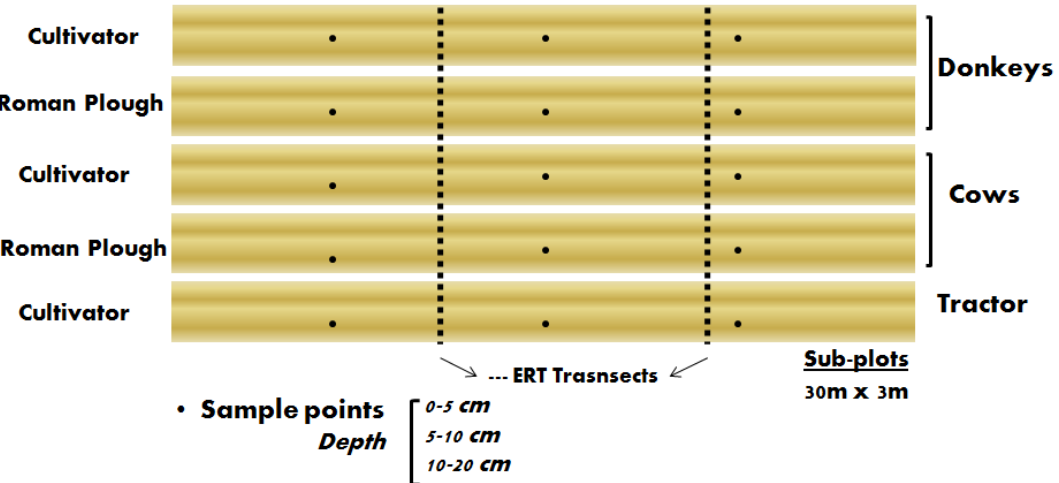
Figure 2: Field experiment scheme: treatments, soil sampling and ERT transects